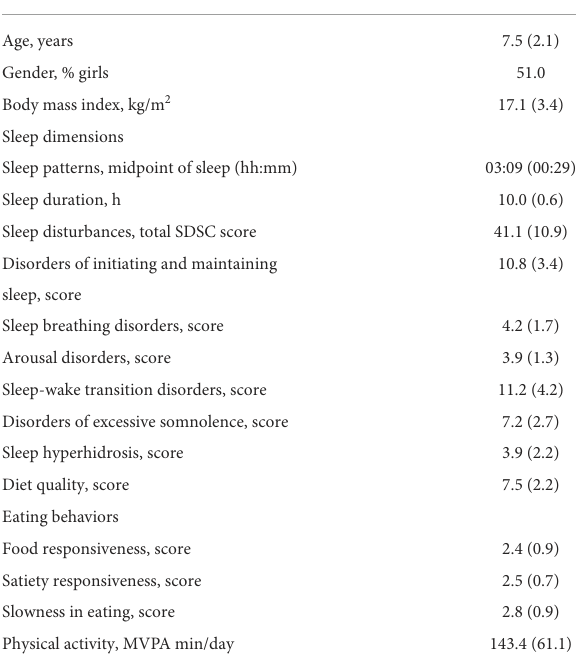
TABLE 1 Characteristics of the population